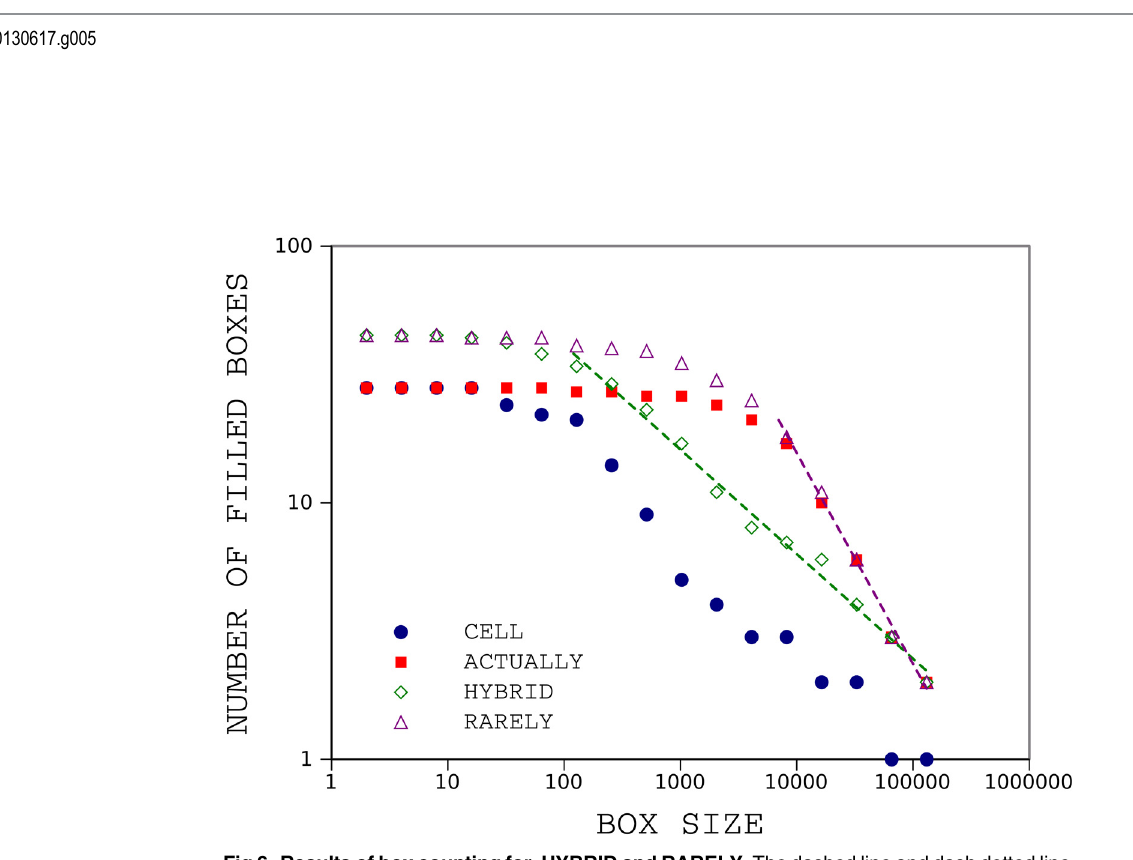
Fig 6. Results of box counting for, HYBRID and RARELY. The dashed line and dash dotted line demonstrate the power law regression. The fractal dimension is about 0.4 for HYBRID and is close to 0.8 for RARELY . The box counting result of CELL and ACTUALLY is also showed. The fractal dimension is about 0.4 for CELL and is close to 0.8 for ACTUALLY